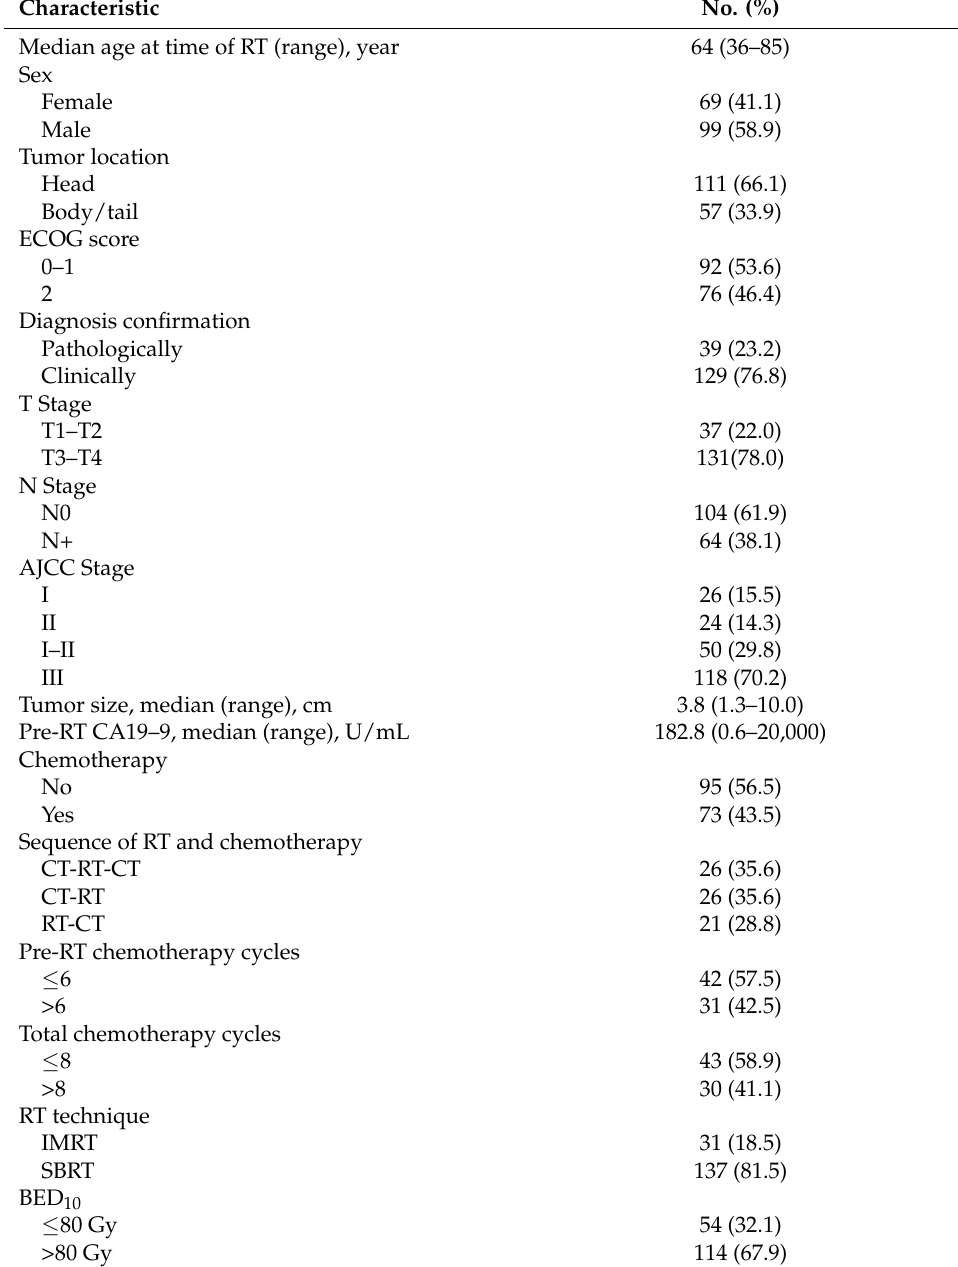
Table 1. Demographic and Clinical Characteristics of